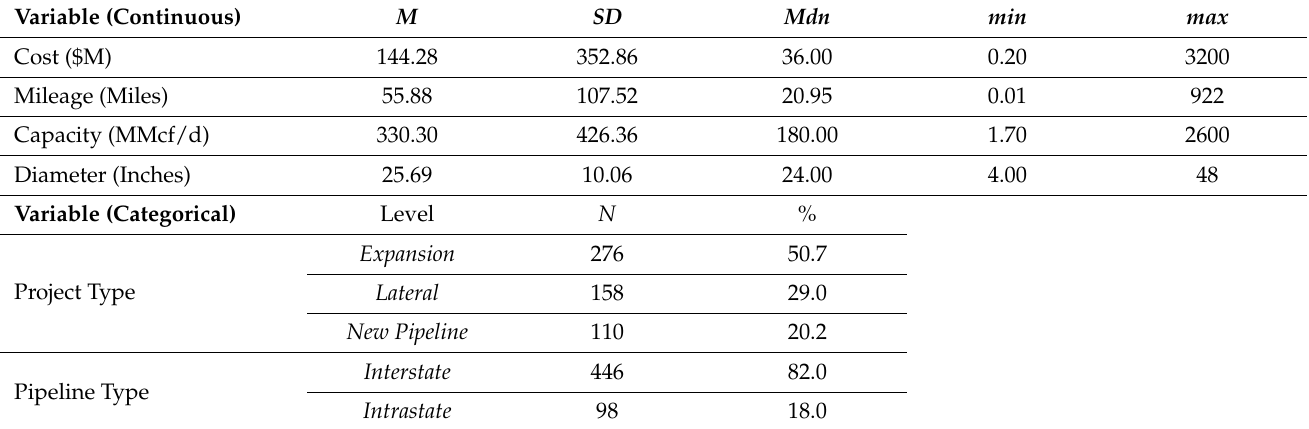
Table 4. Descriptive statistics of variables.